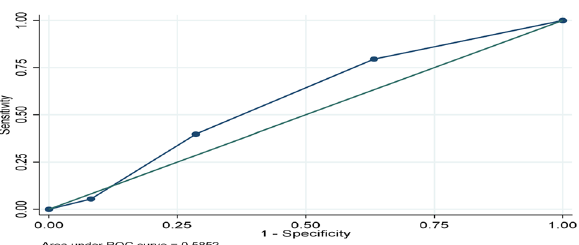
Fig. 13 ROC for PSS. Source: Researchers’